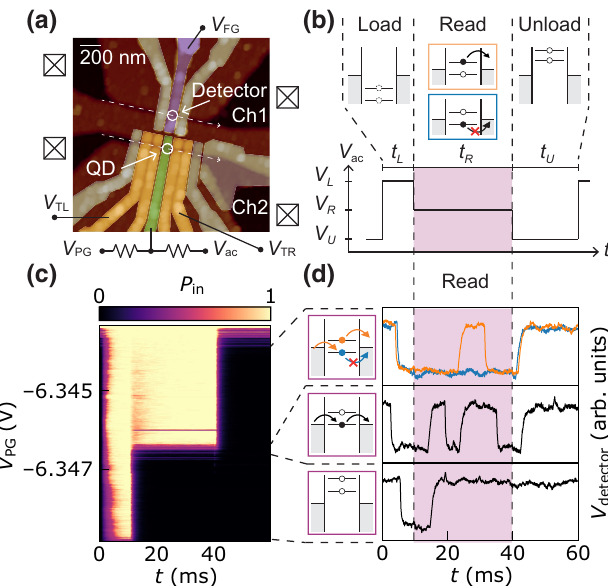
FIG. 3. (a) False-color micrograph of a single QD device with a nearby charge detector. The QD is formed beneath the plunger gate (green) in channel 2. TL and TR serve as tunnel barriers (yellow) to the leads. Another QD is formed under one finger gate (purple) in channel 1 and used as a charge detector. The black squares with crosses inside symbolize Ohmic contacts. (b) Three- level pulse scheme applied to the plunger gate. (c) Probability of the QD being occupied as a function of time and plunger gate dc voltage V PG extracted from 500 single-shot traces. (d) Exemplary traces for different read levels. Top: ideal read-level configuration allowing for single-shot ES-selective readout. Middle: GS level is aligned with E F corresponding to multiple tunneling events. Bottom: both the ES and GS level are pushed above E F during the read phase, which results in a single tunneling-out event.